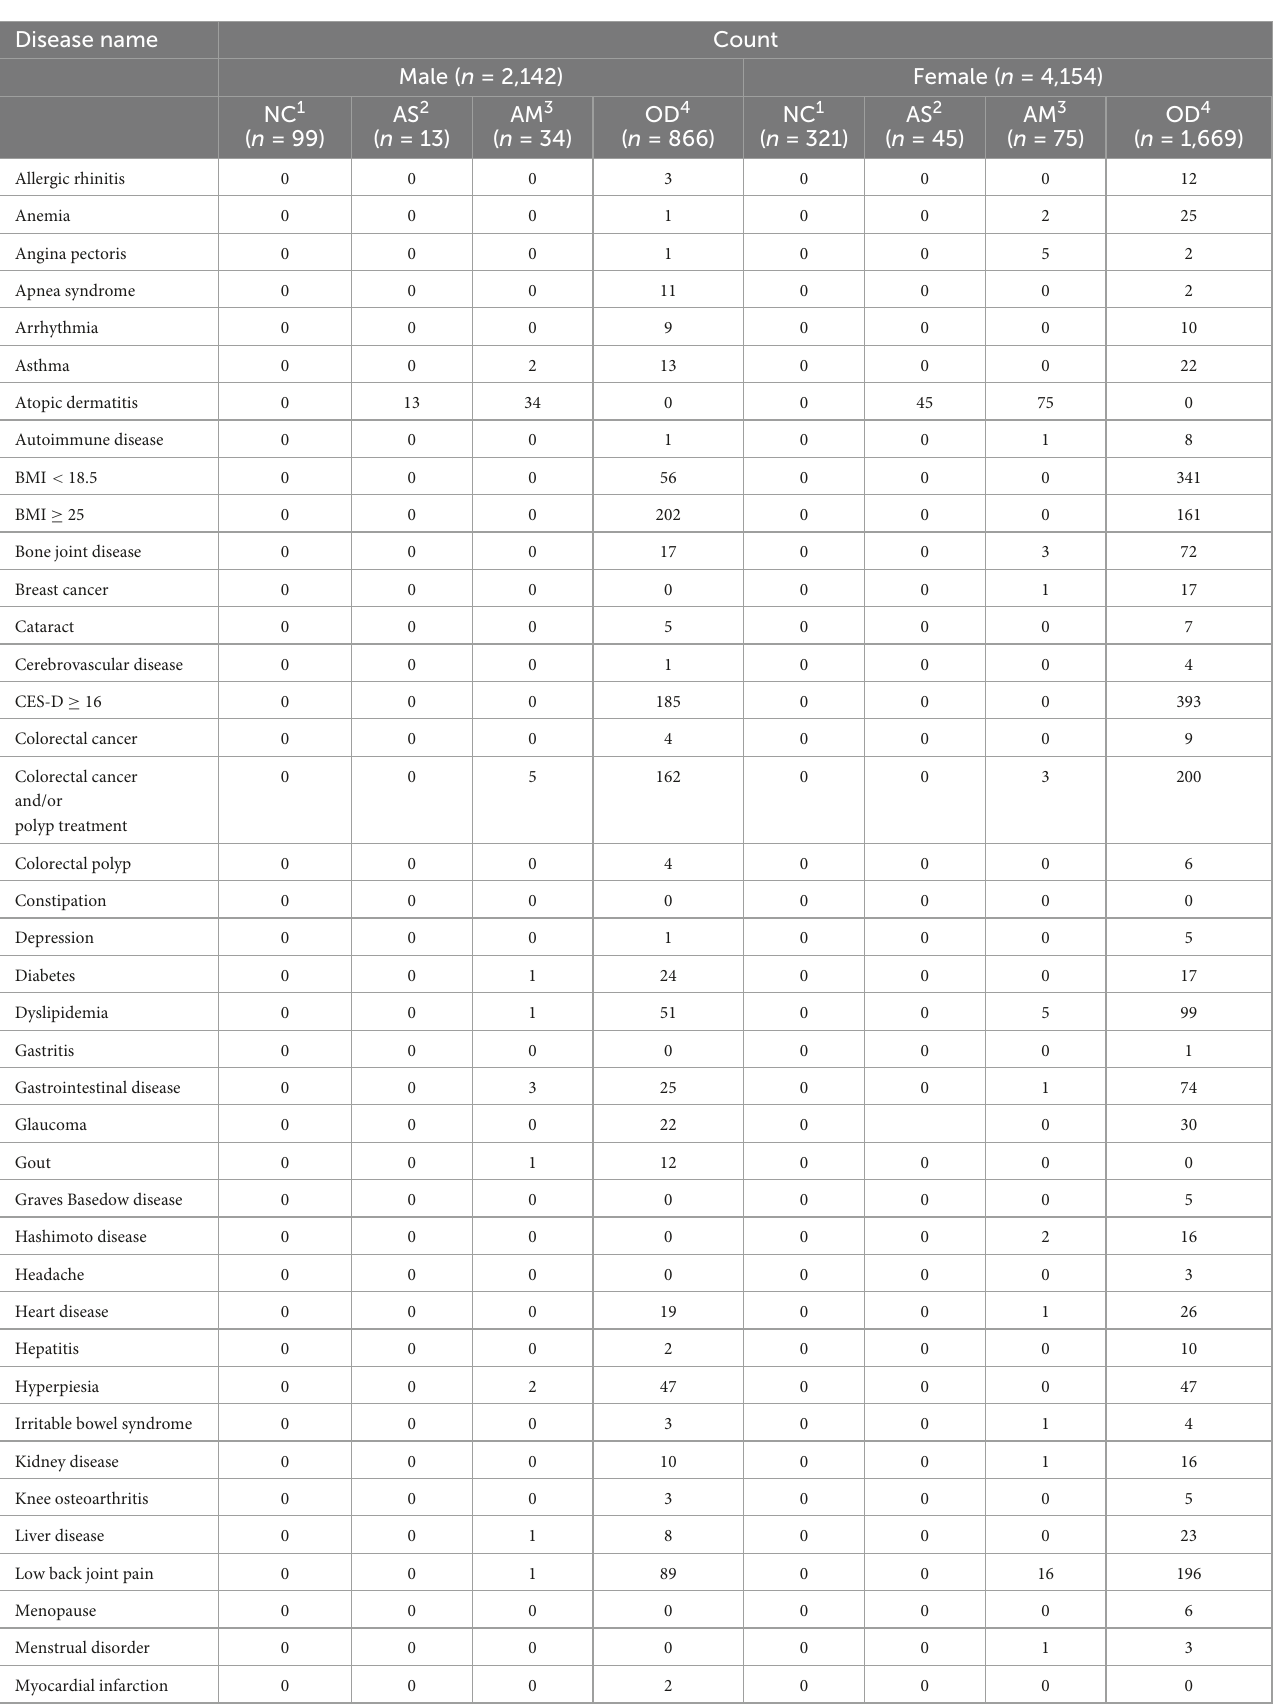
TABLE 2 Disease morbidity in the target populations